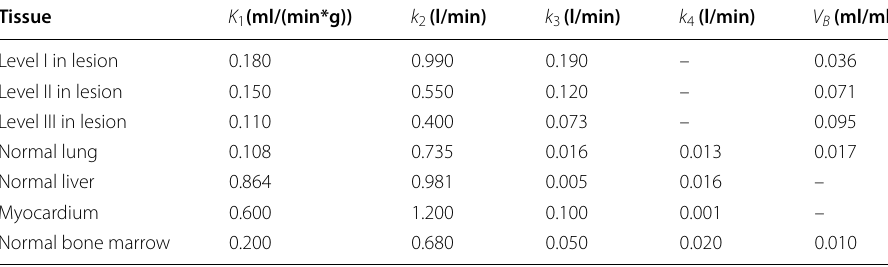
Table 2 18 F-FDG kinetic parameters used to generate time-activity curves in the simulation